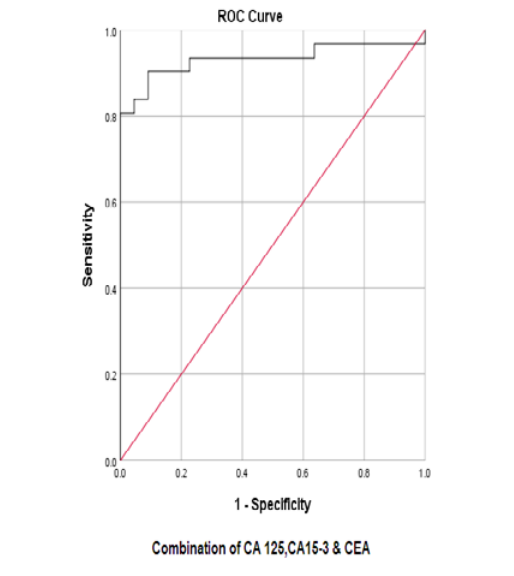
Fig. 4. ROC curve for three tumor markers in combination.